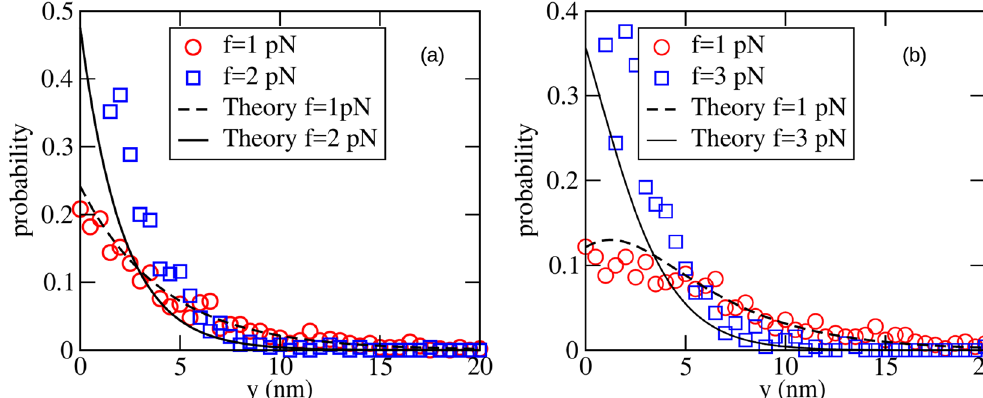
Figure 5. The gap distribution for a = 10 nm, for two forces, far from and near to stall, with ( a ) N = 1 and ( b ) N = 2. Fits of the analytical results, Eq. 28 for N = 1 and Eq. S43(Supplementary Information) for N = 2 are also shown for the best fit value λ = 0.275 nm − 1 , with k on ( ∞ ) = 7.5 s − 1 . For both ( a ) and ( b ), k off = 2 s − 1 . The other parameter values are listed in Table 1.